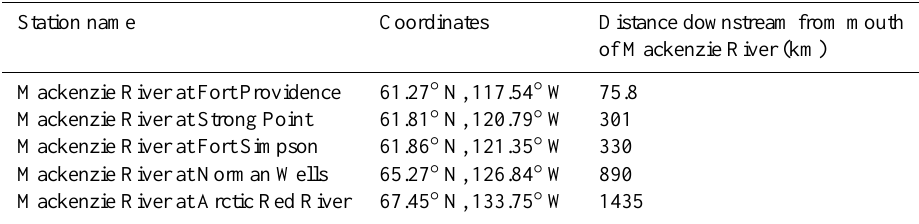
Table 1. Description of a water survey of Canada hydrometric stations on the Mackenzie River.